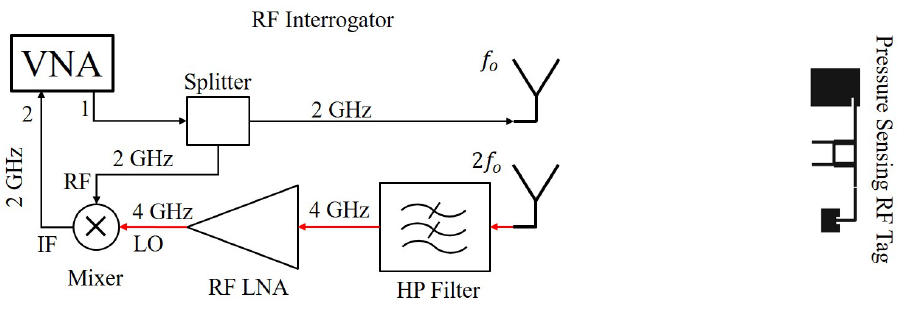
Figure 9. Schematic of the harmonic RF Interrogator consist of a VNA for RF source and phase measurement unit, transmitting and receiving antennas, and miscellaneous RF peripheral circuits for communicating with the harmonic RF sensor